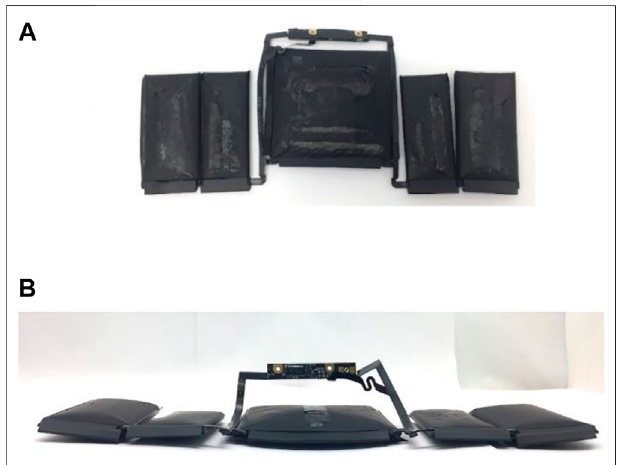
FIGURE2| SwollenMacBookPro2011batteries(Apple,2017). (A) Top view of swollen batteries. (B) Side view of swollen